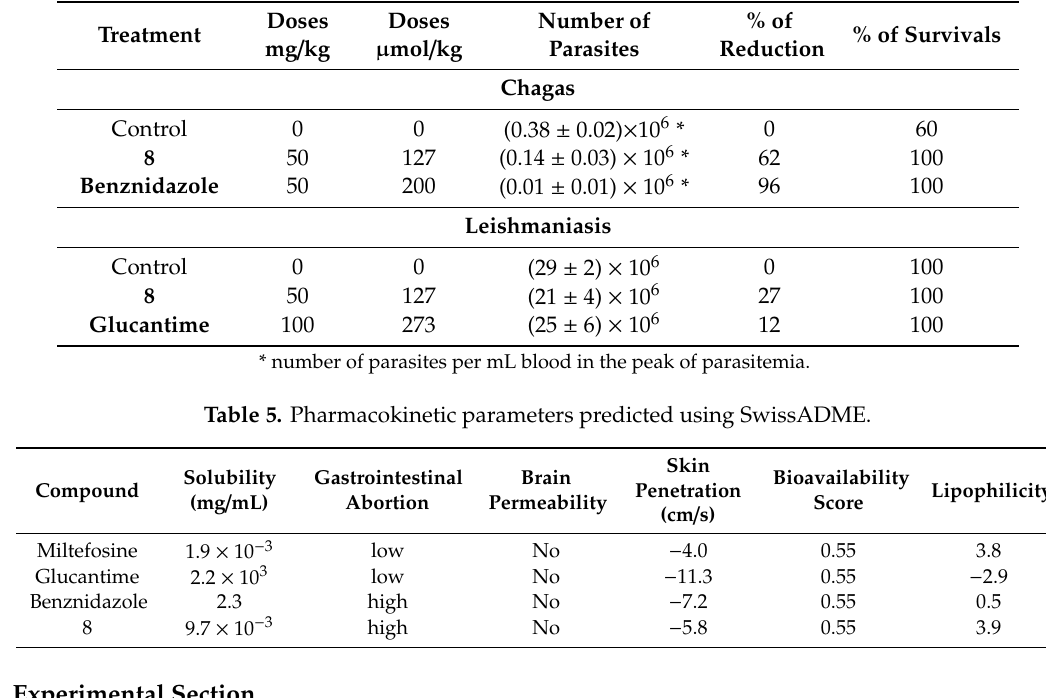
Table 4. In vivo results for the oral administration of 50 mg / kg of compound 8 in mice models of acute Chagas and Leishmaniasis diseases.